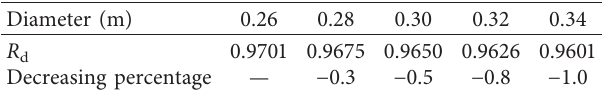
Table 2: Effect of borehole diameter on the end resistance of the existing foundation